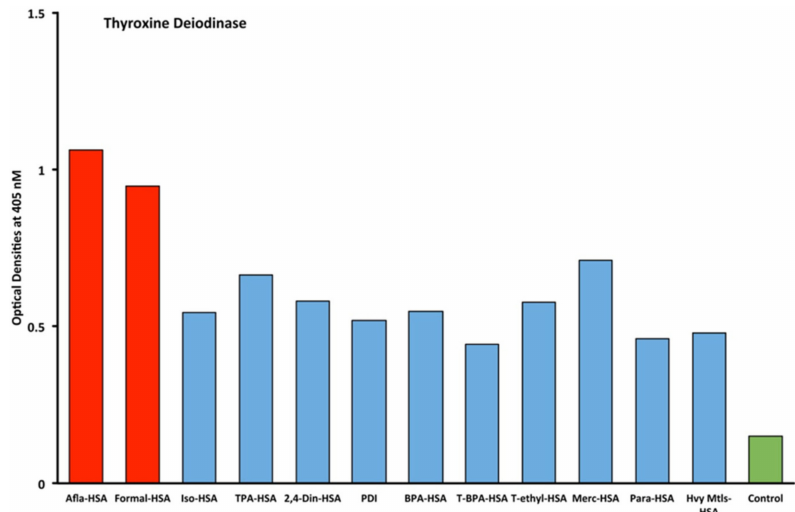
Figure 2. Reaction of thyroxine deiodinase polyclonal antibodies with di ff erent chemicals bound to human serum albumin. The antigens in red represent OD levels that are above the control and also 1 standard deviation above the mean of all 84 single measurements of chemicals bound to HSA. The antigens in blue are less than 1 standard deviation above the mean. The control is in